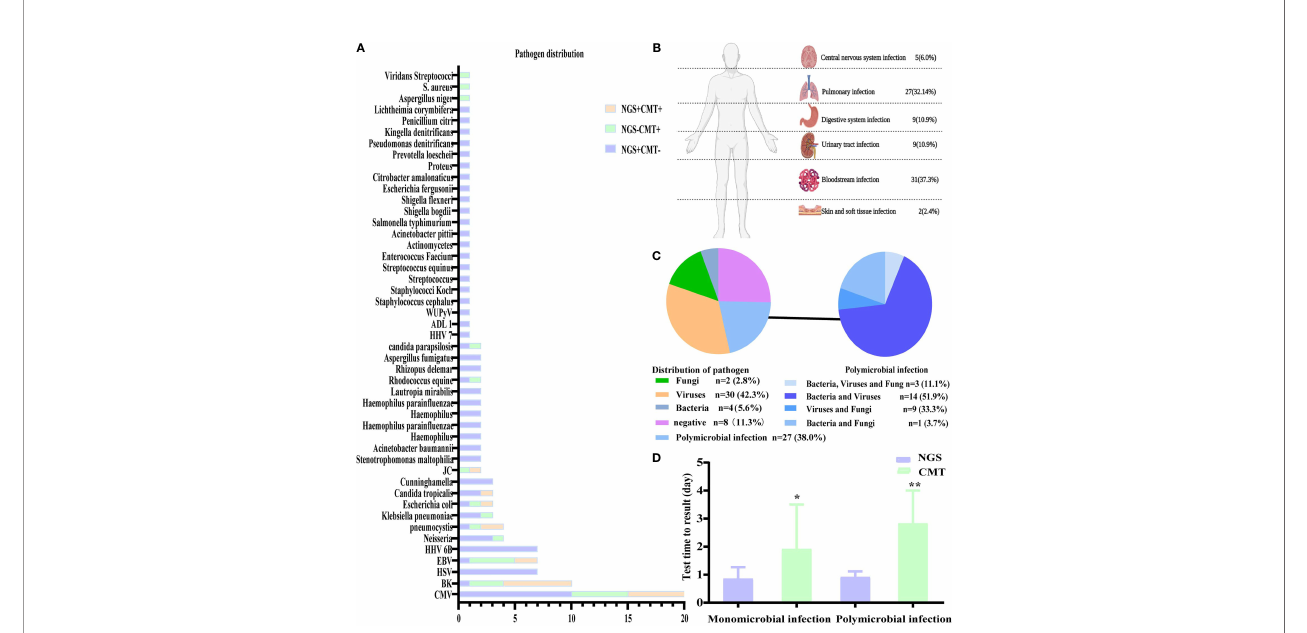
FIGURE 1 | Distribution of pathogens identi fi ed in patients with fever after allo-HSCT using CMT versus NGS. (A) The fi gure showed the number of subjects in whom each causative microbe was detected. Orange bars indicate microbes detected by CMT and also predicted as pathogens by NGS (CMT+NGS+). Purple bars indicate microbes detected by NGS only (CMT − NGS+). Green bars indicate the number of cases with microbes detected only by CMT (CMT+NGS − ); (B) distribution of types of infection was shown from patients with clinical diagnosis; (C) distribution of pathogens was shown from patients. Polymicrobial infection accounted for 38.0% among all the subjects and different kinds of polymicrobial infection were also shown in the right; (D) the diagnostic time required for NGS and CMT were compared in subjects with monomicrobial infection or polymicrobial infection. *P<0.05; **P<0.001 by Wilcoxon rank-sum test.